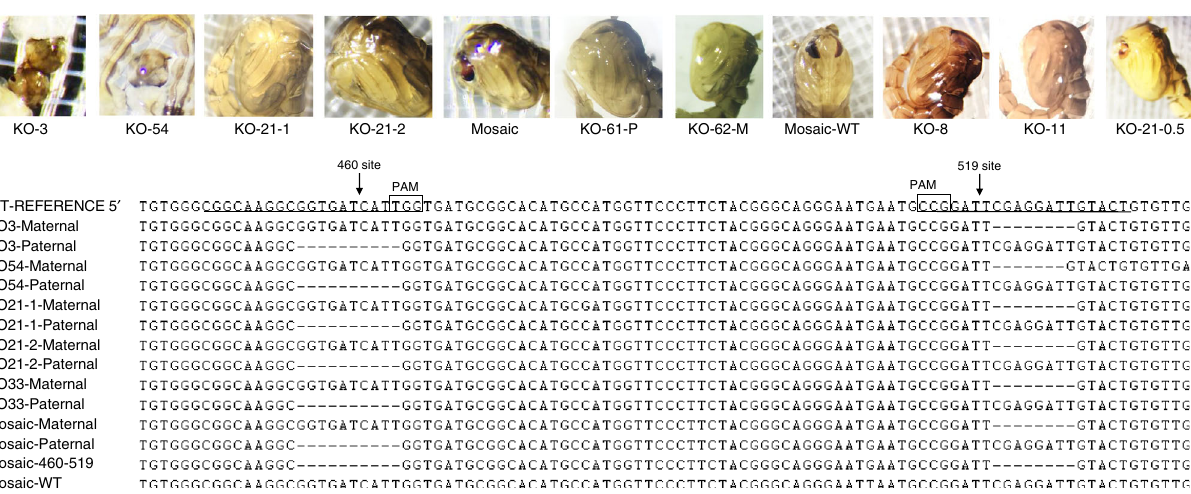
We calculated ef fi ciency of ReMOT Control-mediated maternal editing ef fi ciencies to embryo injections: (i) effort ef fi ciency (EEF;